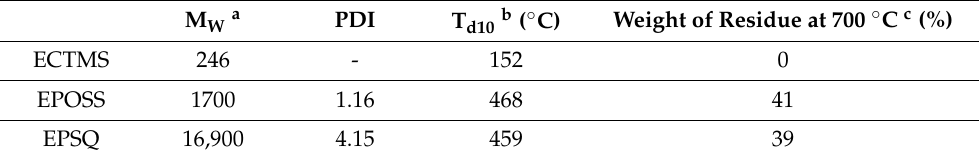
Table 1. Molecular weight and thermal properties of ECTMS, EPOSS, and